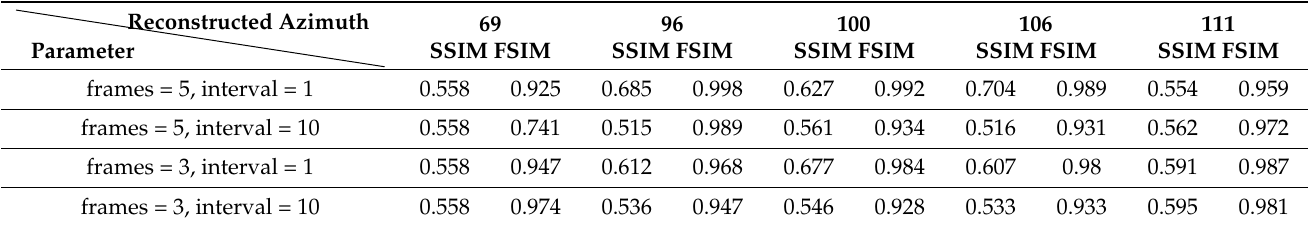
Table 2. Similarity calculation of BTR70 reconstruction results.